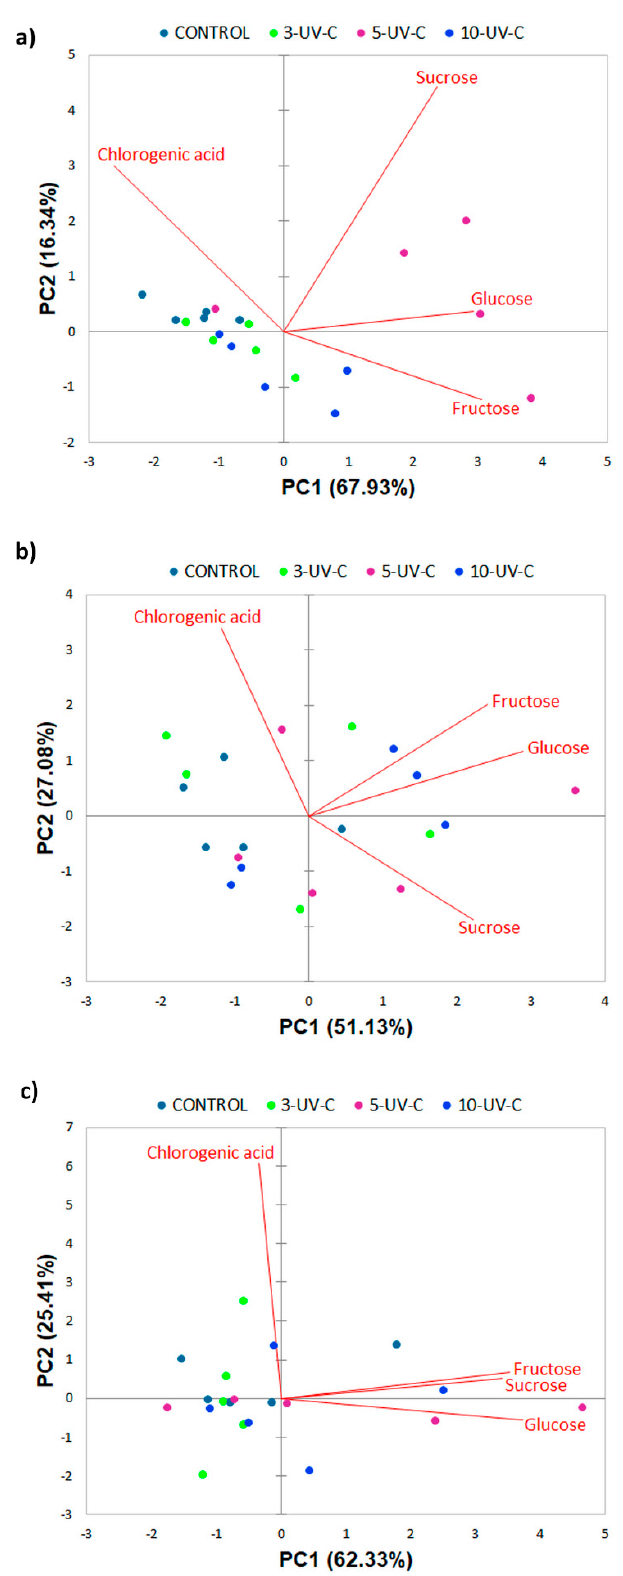
Figure 2. Distribution of ( a ) raw, ( b ) boiled, and ( c ) fried UV-C untreated and treated fresh-cut potatoes in two-dimensional coordinate system defined by the first two principal components (PC1 and PC2).